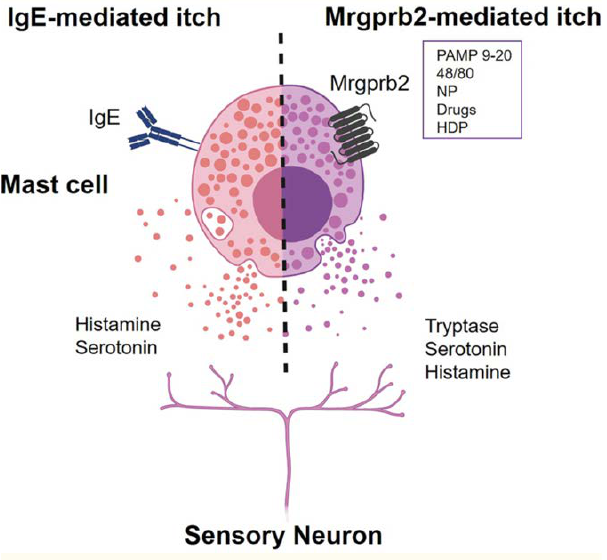
Figure 2. The IgE-mediated versus Mrgprb2-mediated itch axis. The classical activation of mast cells by IgE results in the release histamine and serotonin. Mrgprb2 (murine)/MRGPRX2 (human) can be activated by various cationic substances, such as pro-adrenomedullin peptide 9–20 (PAMP 9–20), compound 48/80, drugs, neuropeptides (NPs), and host defense peptides (HDPs). The Mrgbprb2- mediated activation of mast cells elicits distinct mechanisms of itch from classical IgE stimulation, in which tryptase is a major mediator while others such as histamine and serotonin are also included. (Copyright permission to reproduced this Figure has been obtained from